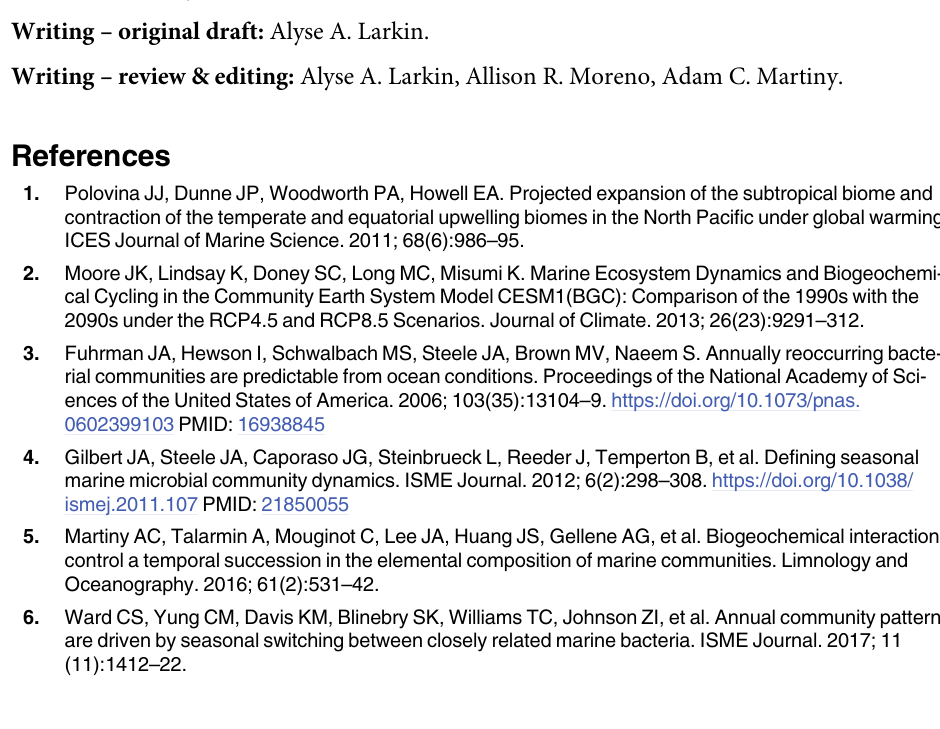
S1 Table. Pearson’s correlation coefficients ( r ) and corresponding p -values for the compar- ison of seasonal (month) and interannual (year) environmental trends to taxa-specific